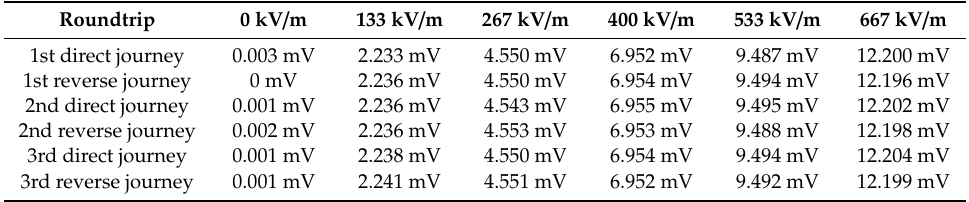
Table 2. The detailed test results of the response characteristics for 50 Hz power frequency fields.